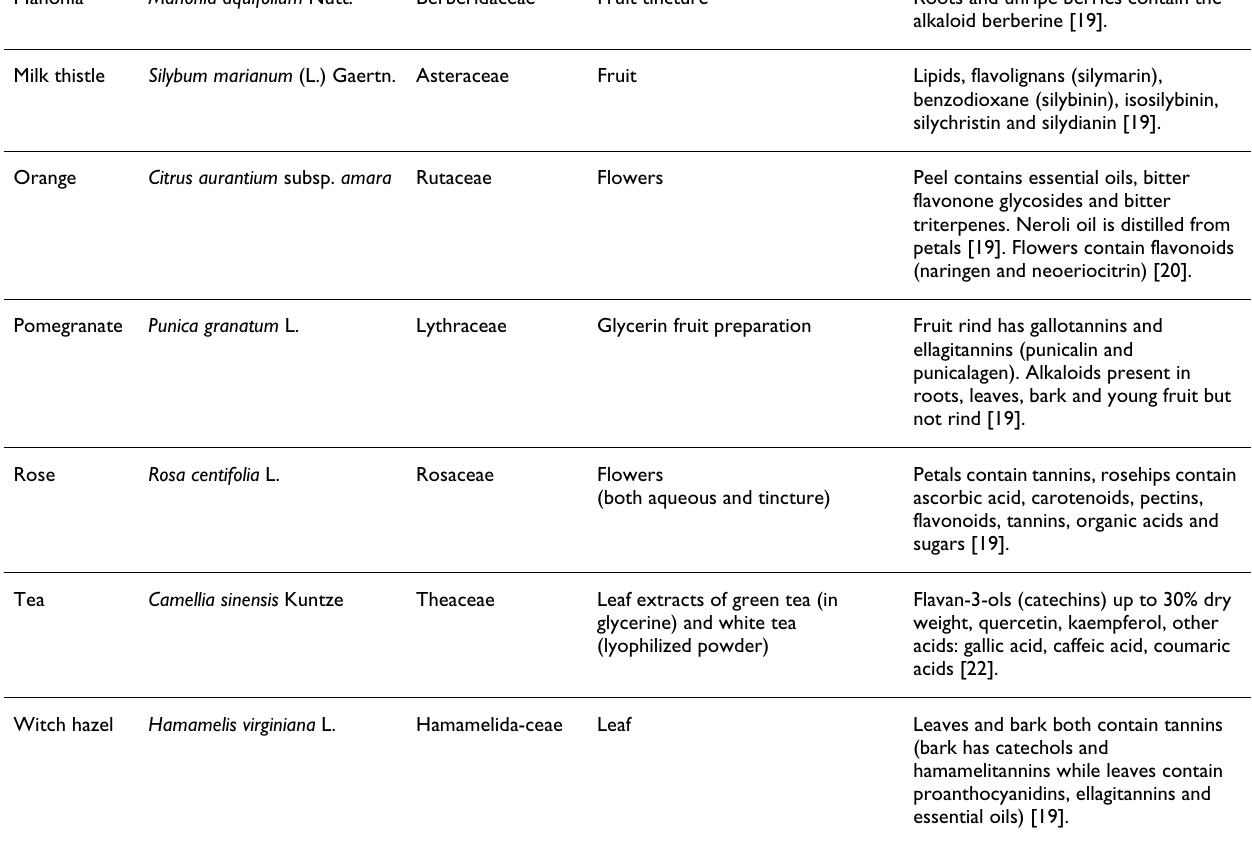
Table 1: Plant extracts used in this study and some of their common chemical constituents